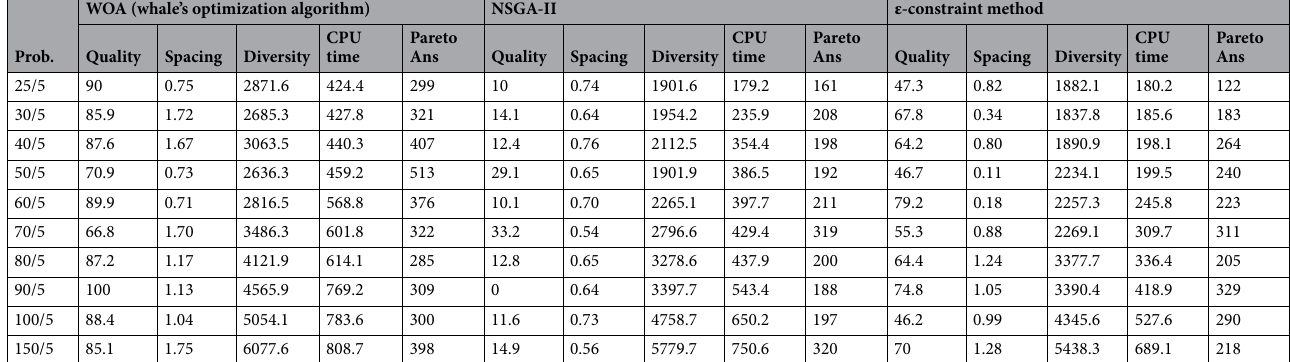
Table 10. Results for solving problems of large and medium-size.